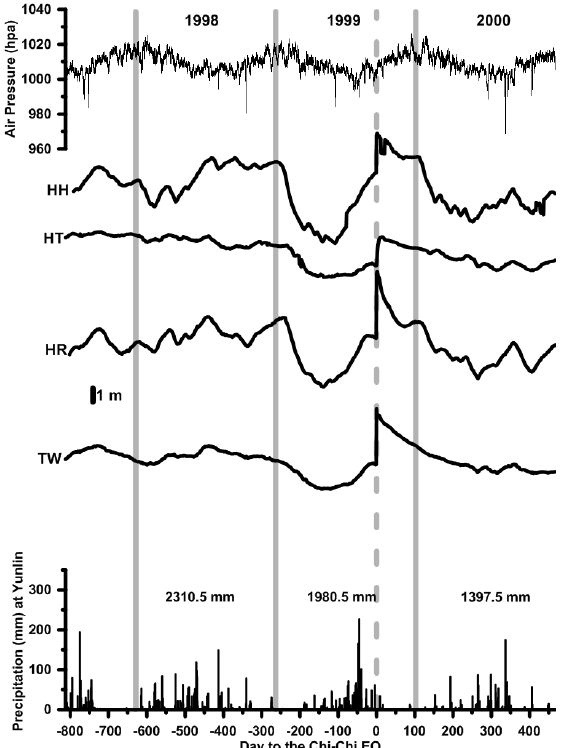
Figure 3. Variations of air pressure, groundwater level at HH, HT, HR and TW sites as well as annual precipitations about 800 days before and 450 days after the Chi-Chi